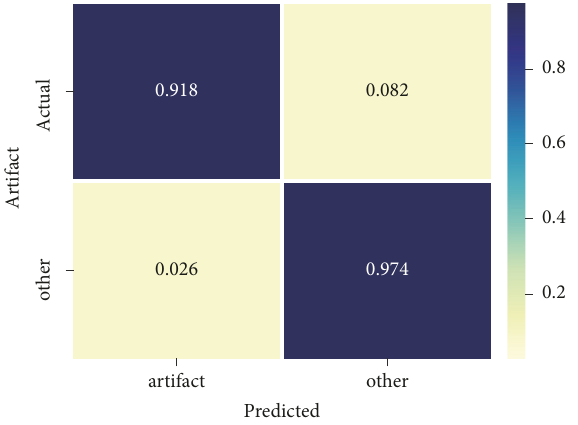
Figure 4: Confusion matrix showing the validation accuracies for thetwodifferentclassesartifactandother(nonartifact).Sensitivityis smaller in comparison to specificity, indicating that the model is less prone to rejecting artifact components compared to the reference method.